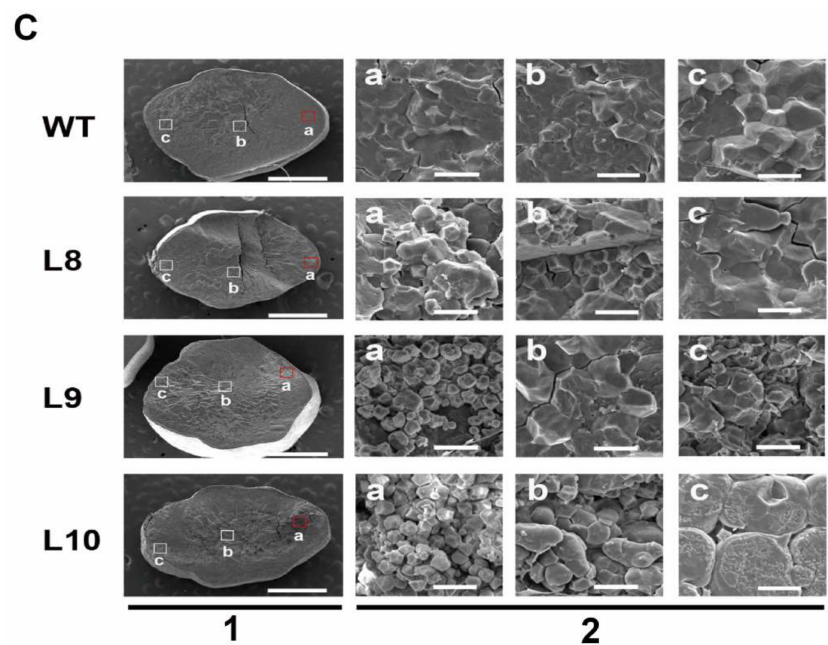
Figure 6. Blue value (BV), maximum absorbance (kmax) and scanning electron microscopy (SEM) images of the transverse sections of transgenic rice seeds. ( A ) BV at 600 nm and kmax represent the ability to combine with iodine. ( B ) BV at 680 nm and kmax represent the ability to combine with iodine. ( C ) Cross-sections of mature seeds are shown in (1). SEM of the ventral area of mature endosperm is shown in a of (2) and indicated by a red square in (1). Bars: 1 mm in ( 1 ); 10 µ m in (2) a: dorsal; b: center; c: